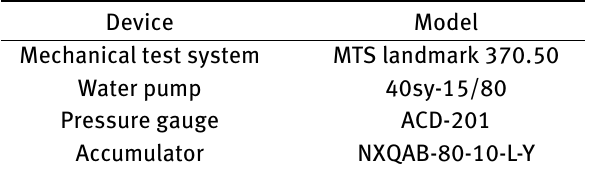
Table 2: Experimental device list.